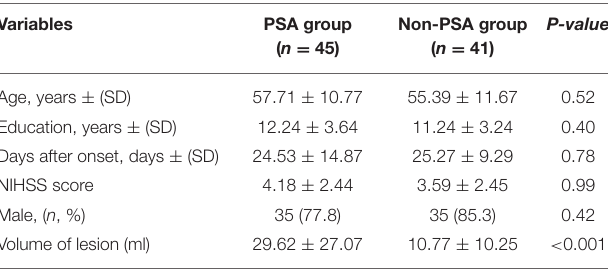
TABLE 1 | General clinical characteristics.